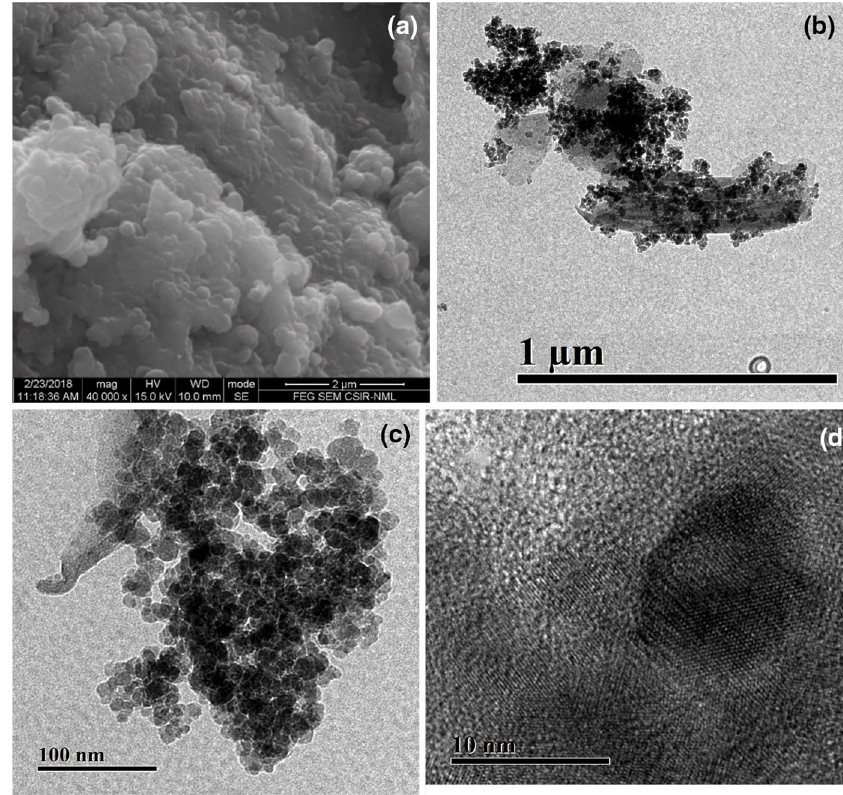
Table 2 Mathematical error functions function